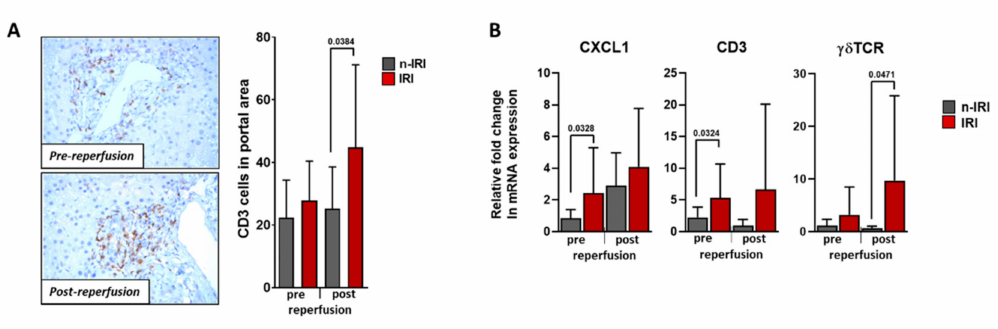
Figure 3. Histological and RT-PCR evaluation of liver allograft biopsies pre- and post-reperfusion. Histological quantification and comparison between patients with an existing or absent IRI ( A ) and RT-PCR analysis of CXCL-1, CD3, and γδ TCR ( B